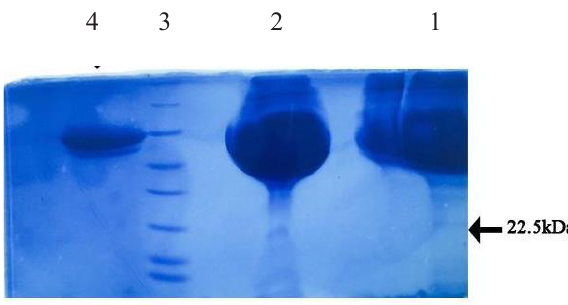
Figure 7. 12.5% Polyacrylamide gel electrophoresis containing the supernatant of transfected cells with and without chemical treatments. Line 1: Supernatant of hIFN β 1a-producing CHO cells without chemical treatment. Line 2: Supernatant of CHO cells producing hIFN β 1a under chemical treatments. Line 3: Unstained protein ladder. Line 4: Negative control